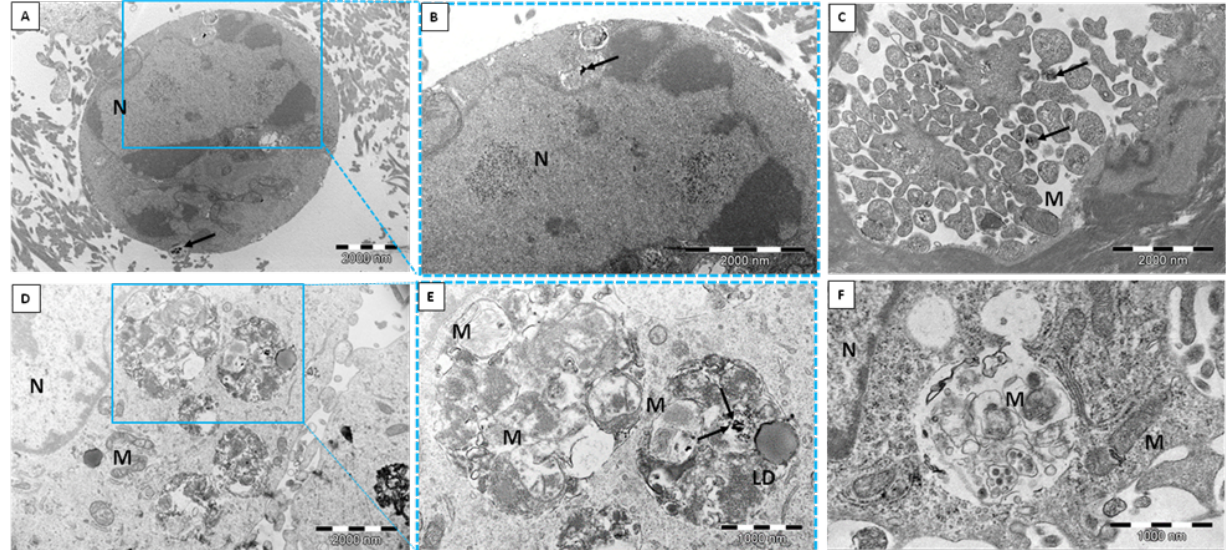
Figure 2. Apoptosis and autophagy of HMEC-1 cell line after exposure to silica nanoparticles. ( A ) and ( B )—cell membrane smoothing; cytoplasm condensation and chromatin rearrangement are clearly visible. C—apoptotic bodies. ( D – F )—the autophagolysosomes with different, partially di- gested, contents. Arrows—SiO 2 nanoparticles; N—nucleus, LD—lipid droplets; M—mitochondria. ( A , B , D , E )— pyr SiO 2 ; ( C ) and ( F )— bio SiO 2 .